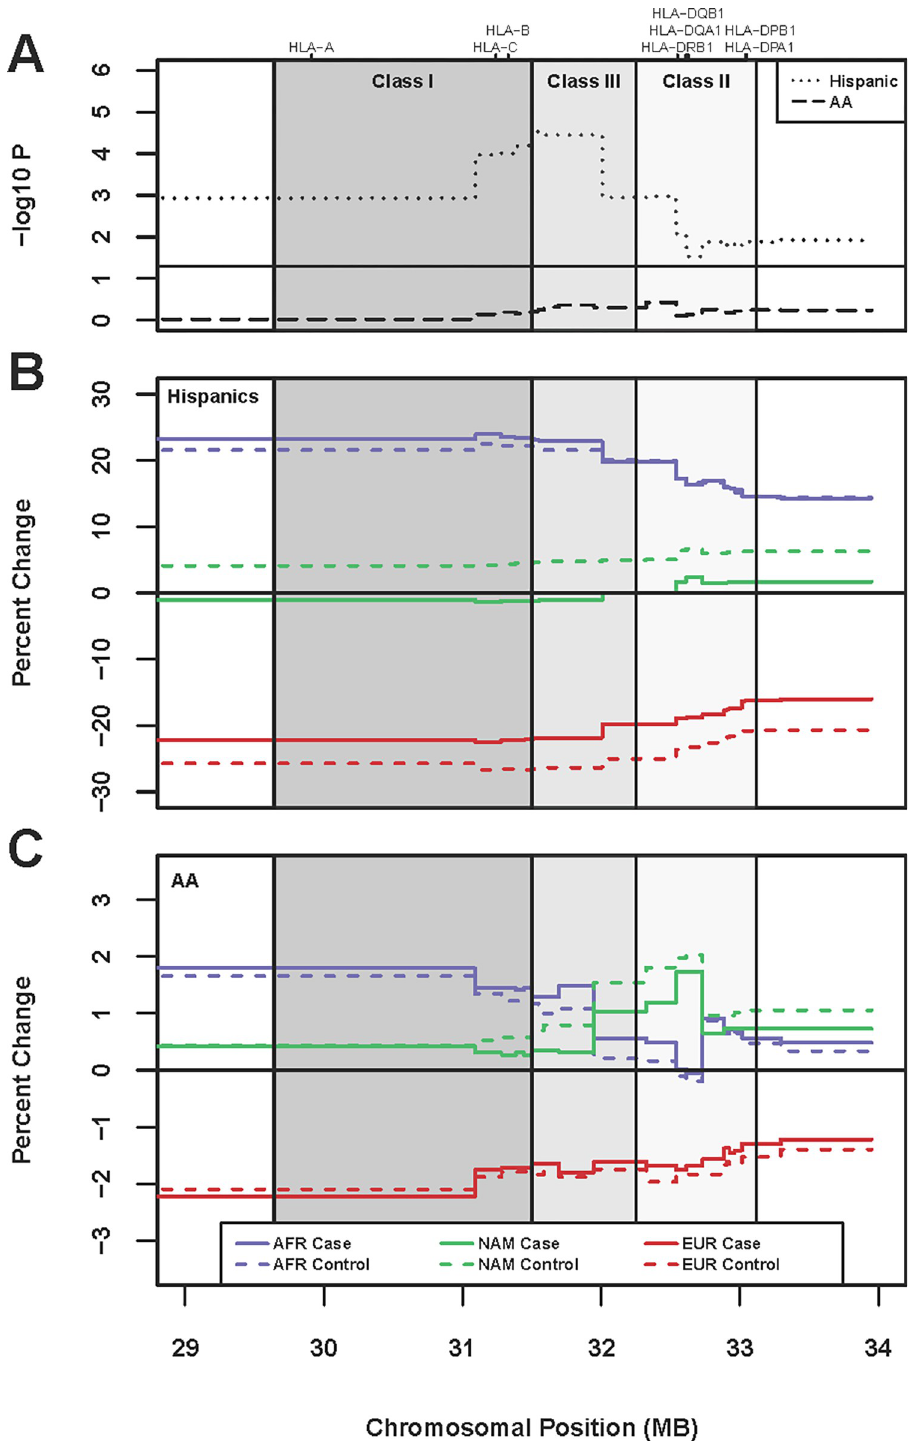
Fig 3. Local ancestry across the MHC. A. Association with MS case status. p-values from the likelihood ratio test for the effect of local ancestry on MS case status are depicted on the Y-axis and position in MB (HG19) on the x-axis. We find association of local ancestry with MS case status (p < 0.05, i.e. -log10P = 1.3) across the entire MHC in Hispanics, but no significance is observed at the same threshold in African Americans. B. Average percent change in local vs global ancestry for Hispanic cases and controls. An increase in African local ancestry and a decrease in European